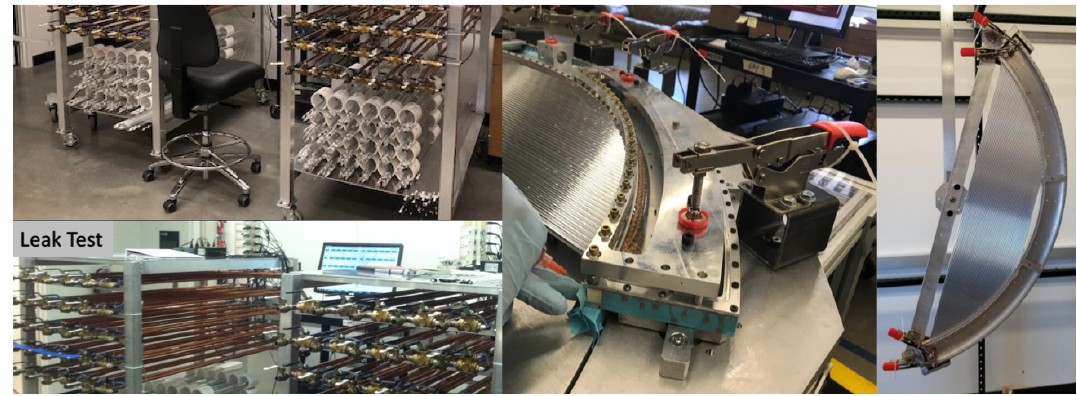
Figure 6. Left: (top) straw storage system, (bottom) leak test. Middle: panel assembly. Right: assembled panel waiting to be leak tested.